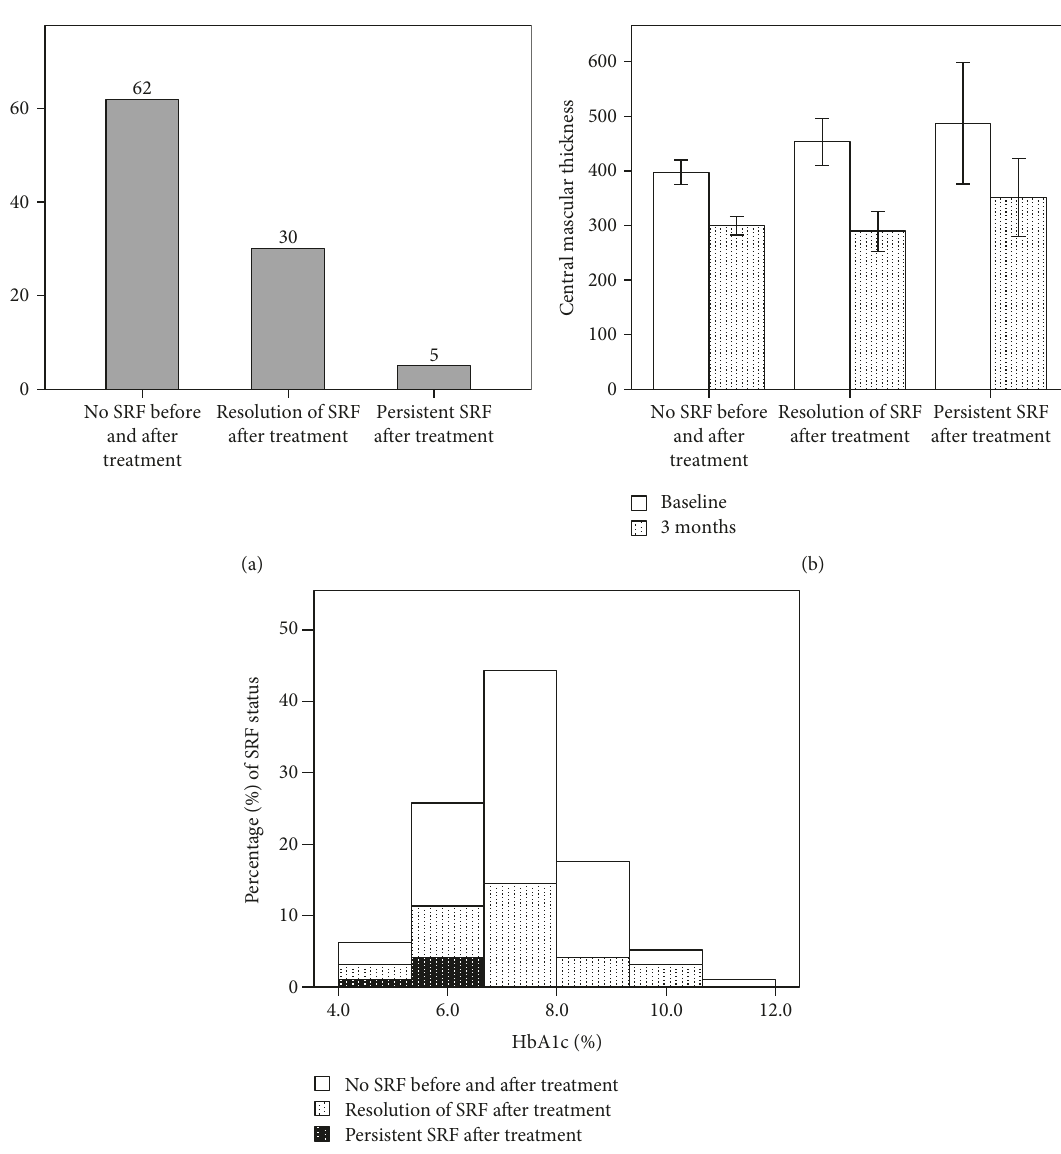
Figure 2: Presentation of clinical parameters according to di ff erent status of subretinal fl uid. (a) Number of eyes with absence of SRF before and after treatment, resolution of initial SRF after treatment, and persistent SRF after treatment. (b) Central macular thickness before and after treatment and (c) HbA1c